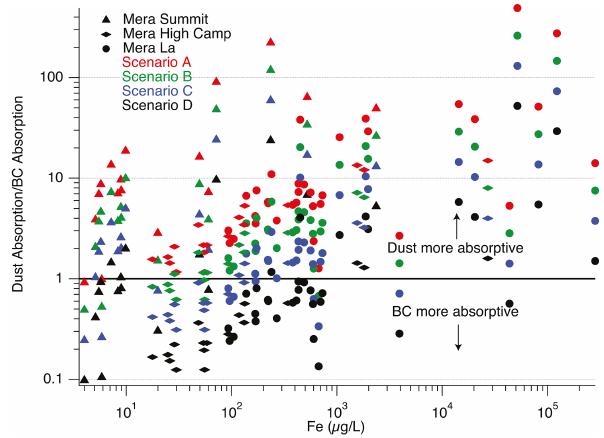
Figure 6. Fe concentrations vs. the calculated dust absorption/BC absorption for all snow samples presented in Fig. 4 of the manuscript based on the four scenarios described in the text.